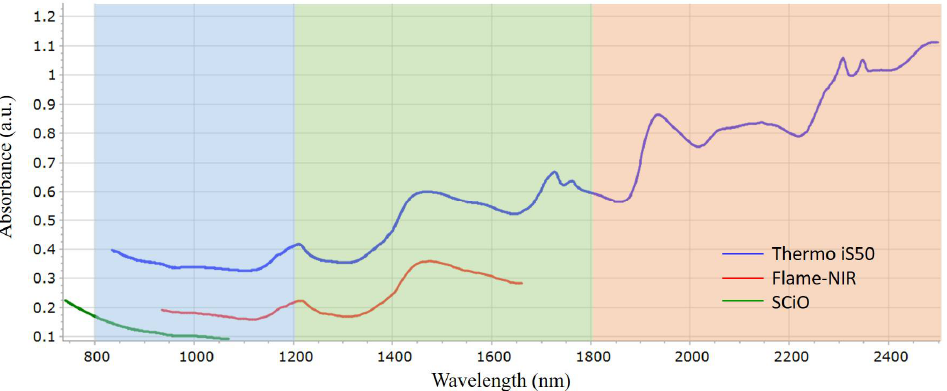
Figure 1. Average spectrum of authentic coriander seed samples assessed using the Thermo iS50 (blue), Flame-NIR (red) and SCiO (green). The background colors represent the three NIR regions, blue (region 1), green (region 2) and orange (region